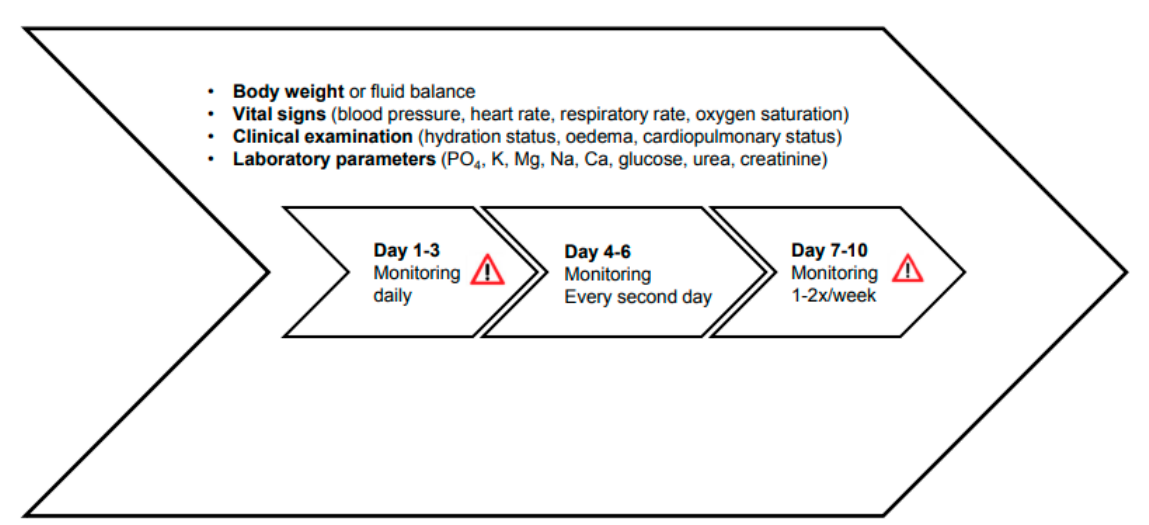
Figure 5. Monitoring of RFS. Reprint with permission from Ref. [24]. 2017, Division of Diabetes, Endocrinology, Nutritional Medicine and Metabolism, University Hospital, Bern.